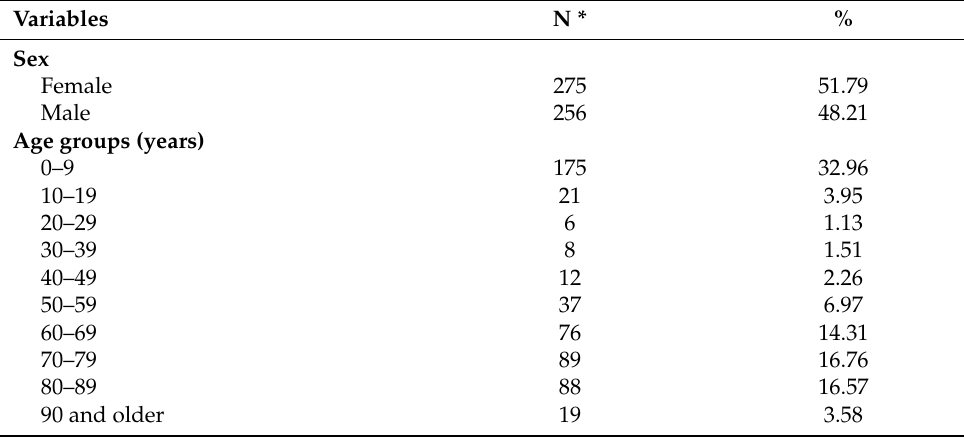
Table 1. Characteristics of patients with community-acquired